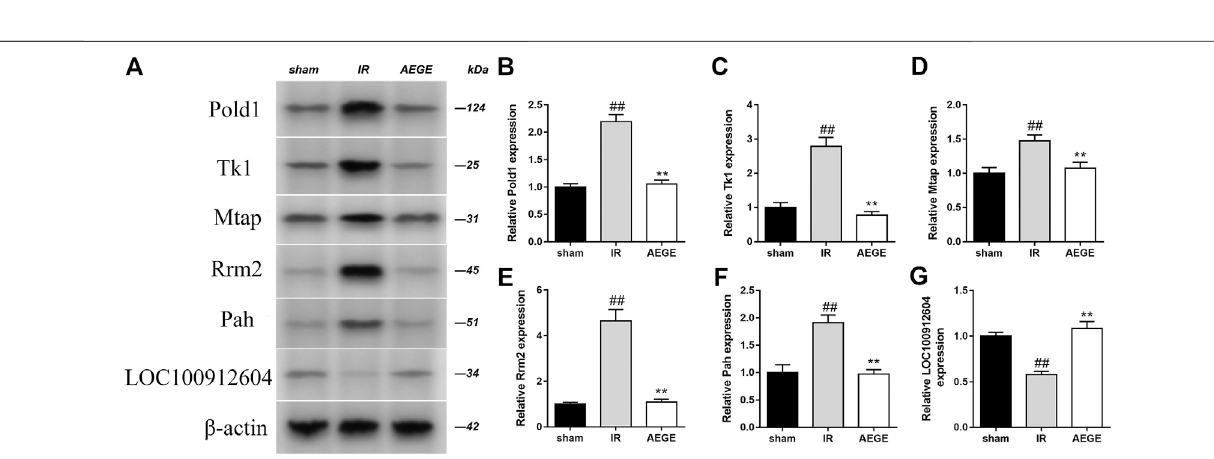
Frontiers in Pharmacology |